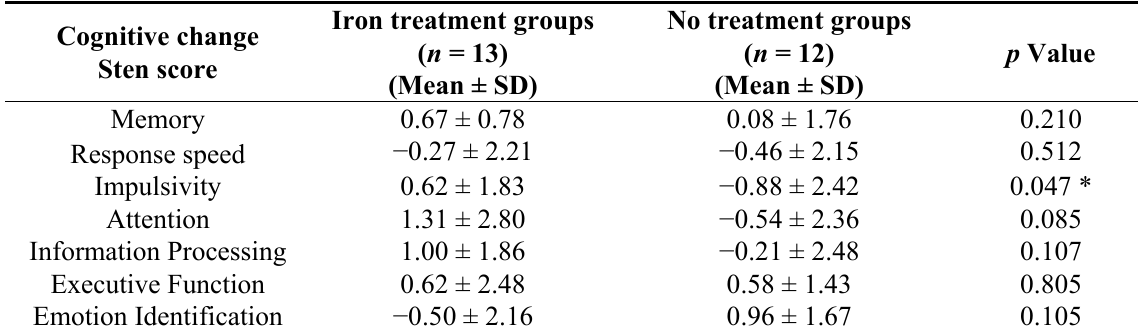
Table 2 . Cognitive domain change scores for iron treatment and no treatment